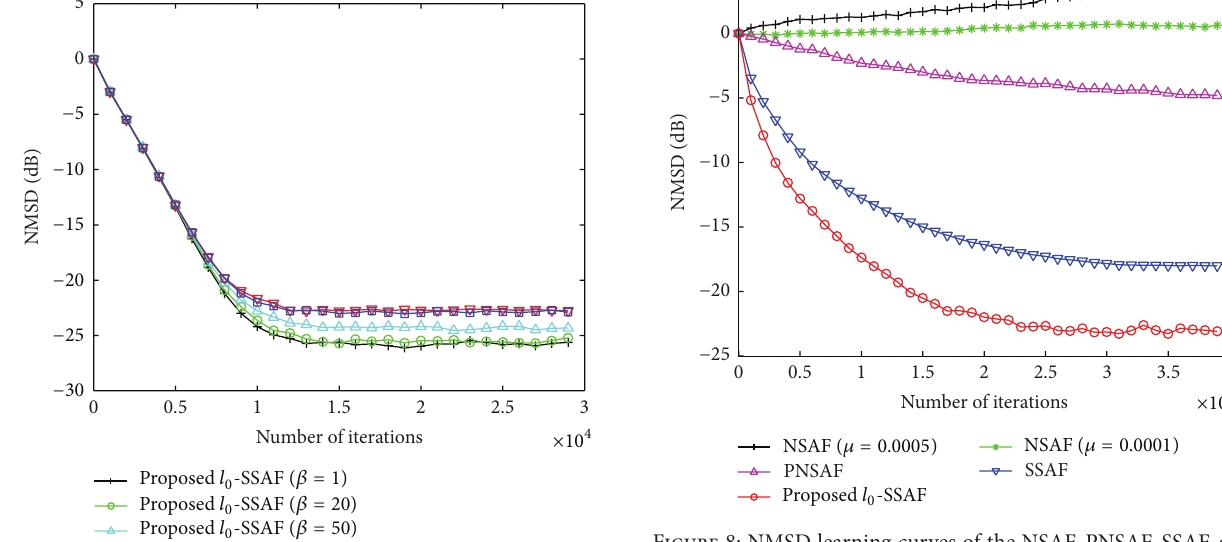
Figure 8: NMSD learning curves of the NSAF, PNSAF, SSAF, and 𝑁 = 4 ,SIR = −30 𝑙 0 -SSAFalgorithms[ 𝛽 ( 𝛽 = 1, 20, 50, 100)